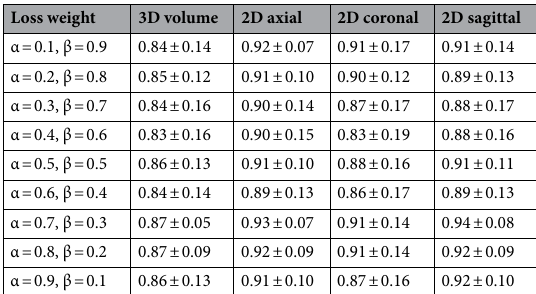
Table 1. Comparison of Dice similarity coefficient scores (DSC) for α, weight of 3D volume loss, and β, weight of the MPL in axial, coronal, and sagittal planes to determine the optimal loss weights for α and β for the